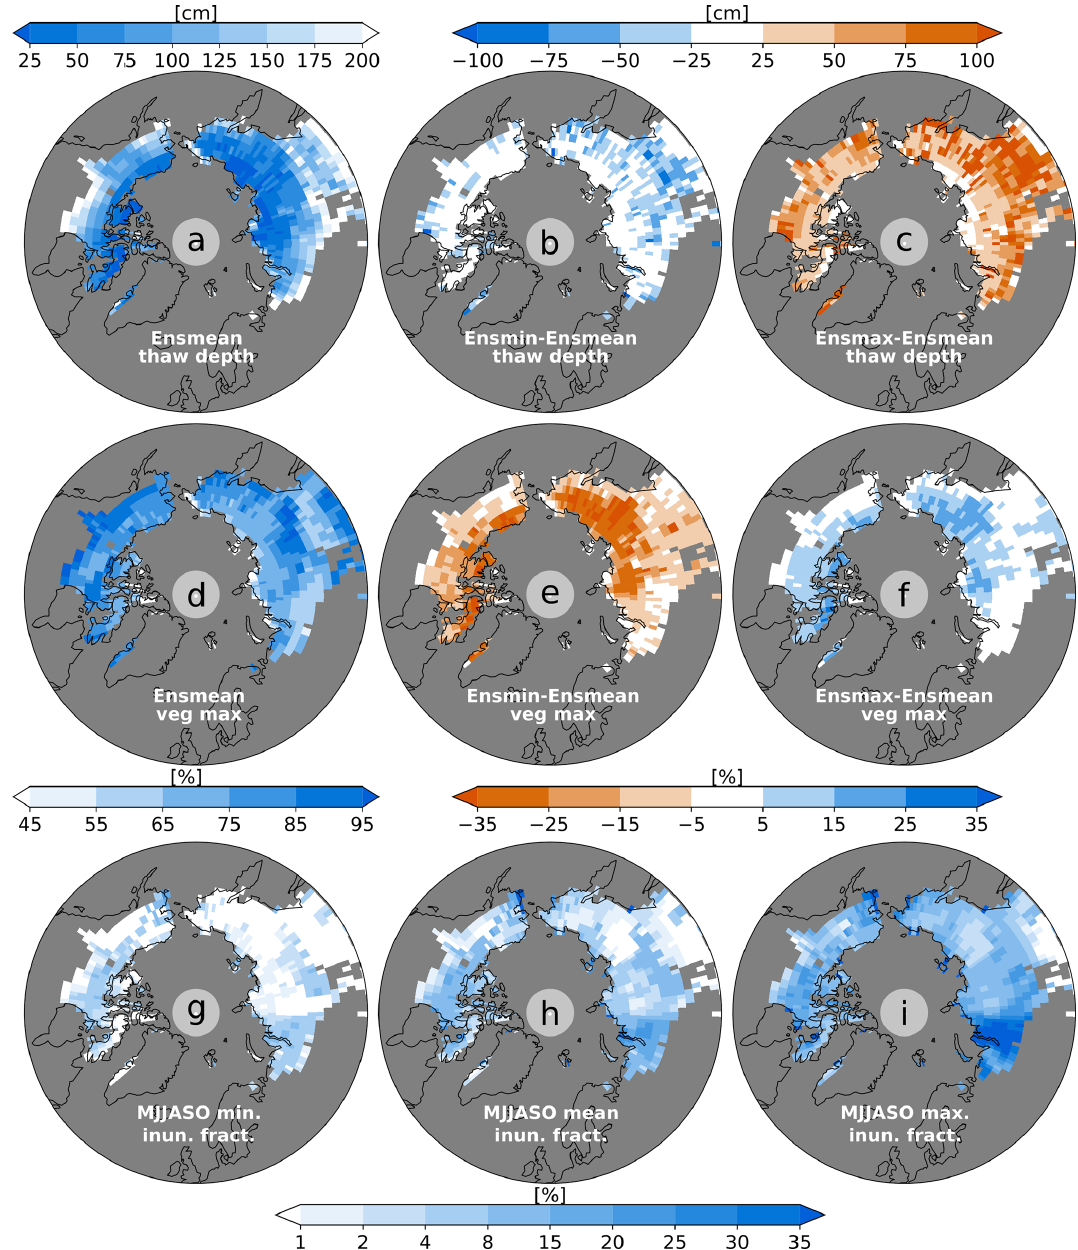
Figure 3. Simulated permafrost, vegetated fraction and inundated areas in the year 2000. (a) Ensemble mean (ensmean) of the annual maximum thaw depth, corresponding to the year 2000 (1990–2010 mean). Grey areas indicate grid boxes in which the annual maximum temperatures throughout the top 3m of the soil exceeded the melting point for more than 10 years in the period 1990–2010. These are considered to be unaffected by near-surface permafrost and are not taken into consideration in the study. (b) Same as (a) but for the difference between the ensemble minimum (ensmin) and mean. (c) Same as (a) but for the difference between the ensemble maximum (ensmax) and mean. (d) Ensemble mean vegetated fraction. Note that this is the maximum grid box fraction that can be covered by vegetation, while the actual vegetated cover depends on the current state of the vegetation and can vary throughout the year. (e) Same as (d) but for the difference between ensemble minimum and mean. (f) Same as (d) but for the difference between the ensemble maximum and mean. (g) Minimum inundated fraction during the summer months (May–October; MJJASO) for the year 2000. Shown is the ensemble mean. (h) Same as (g) but for the May–October mean. (i) Same as (g) but for the May–October maximum inundated